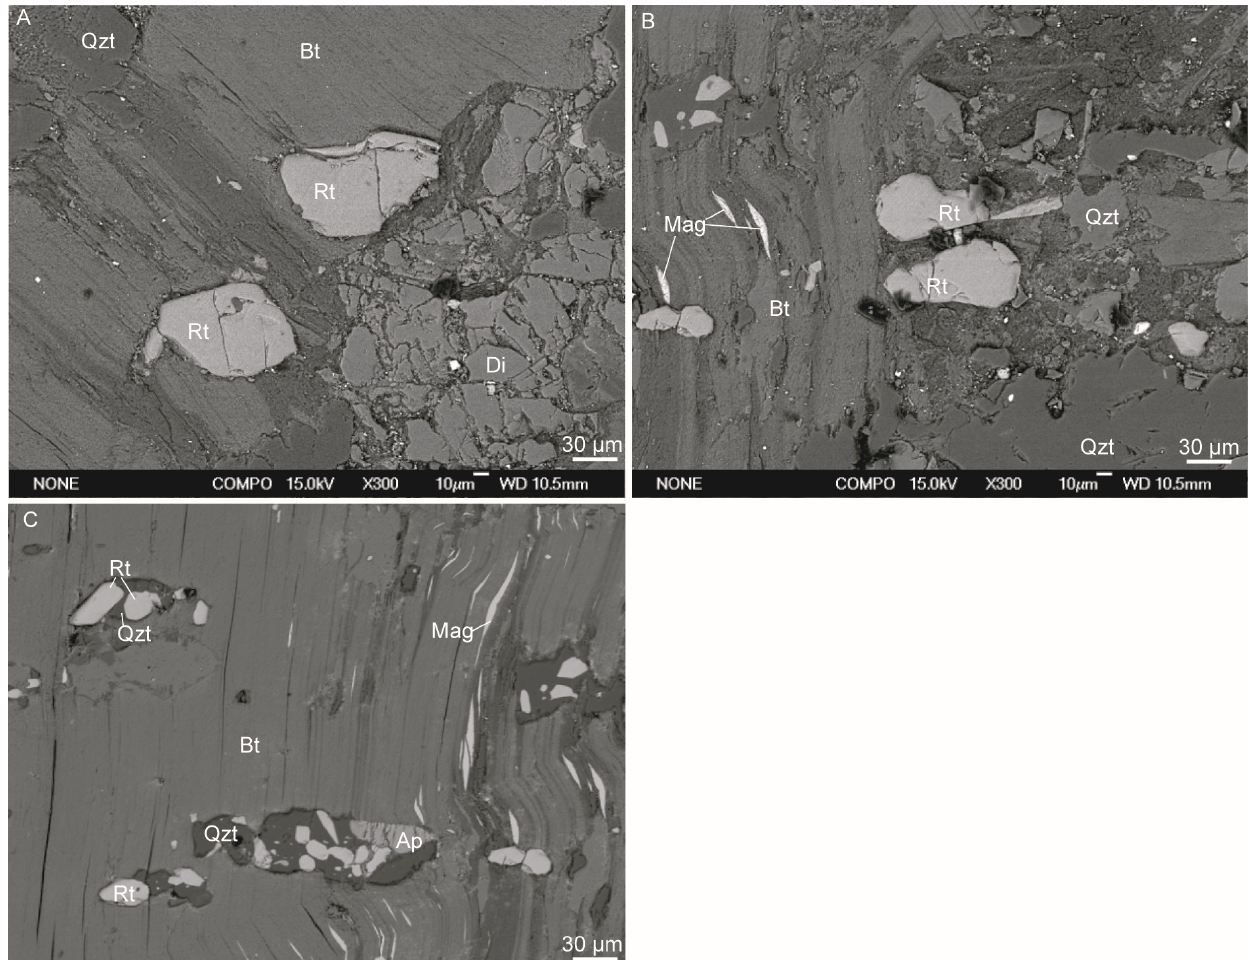
Figure 4. Representative backscattered electron SEM images. ( A ) Isolated rutile grain in biotite; ( B ) rutile and magnetite aggregates growing in or around biotite; ( C ) rutile and quartz aggregates, and magnetite growing in biotite. Abbreviations: Ap = apatite, Bt = biotite, Cal = calcite, Di = diopside, Mag = magnetite, Qzt = quartz, Rt = rutile.